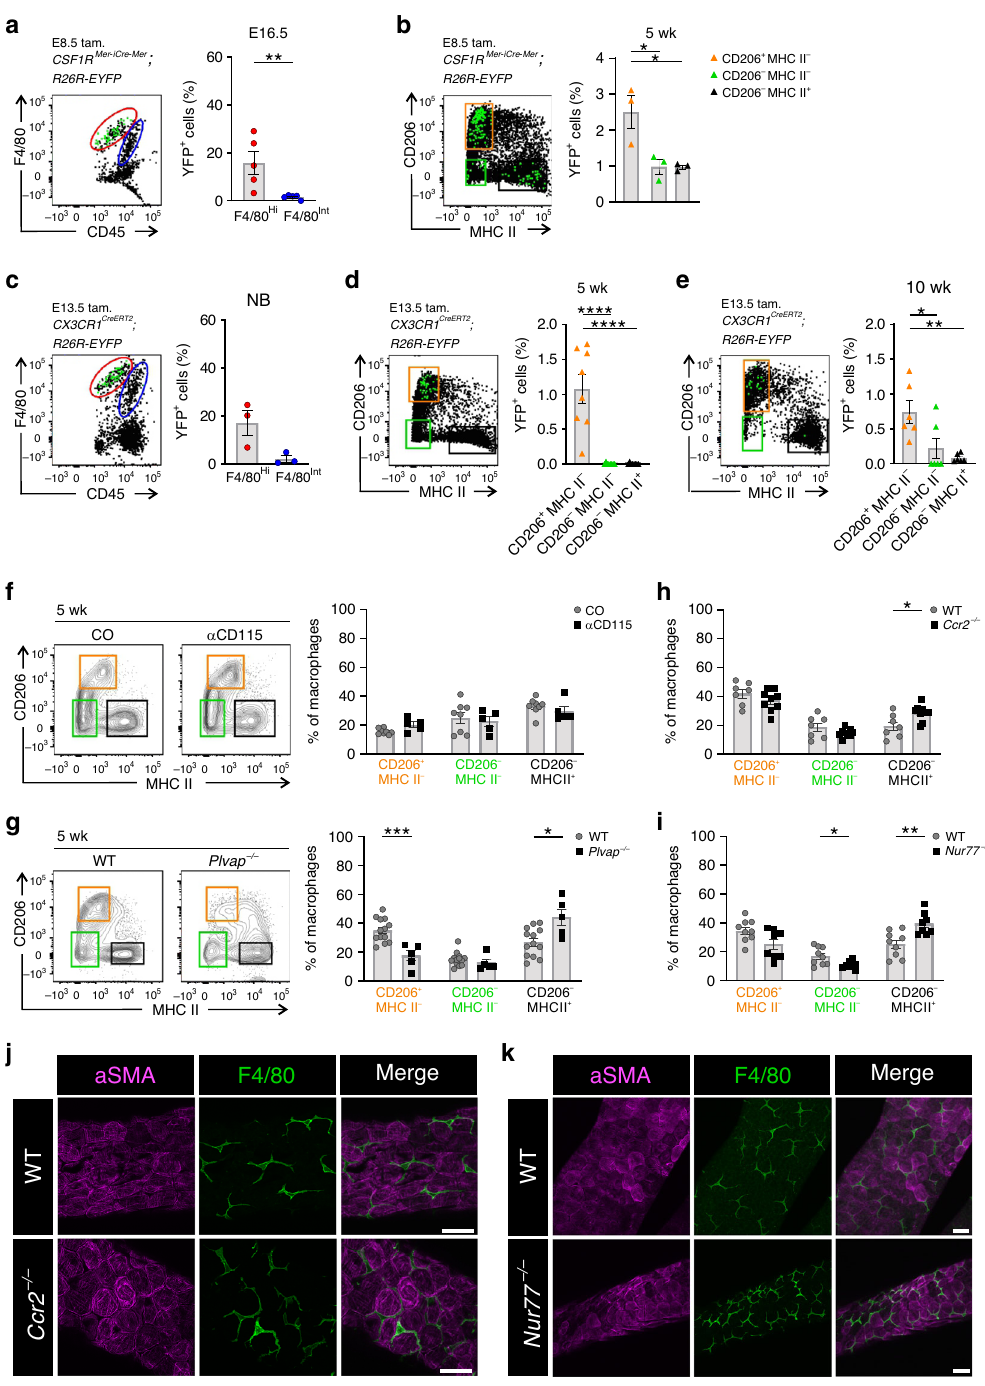
Fig. 4 Fetal-derived macrophages dominate in the postnatal testis. a – e Representative FACS plots and quanti fi cation of yolk-sac-derived macrophages